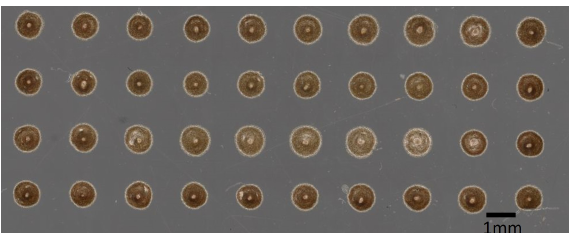
Figure 3. 40-dot adhesive dispensing matrix on test foil substrate.